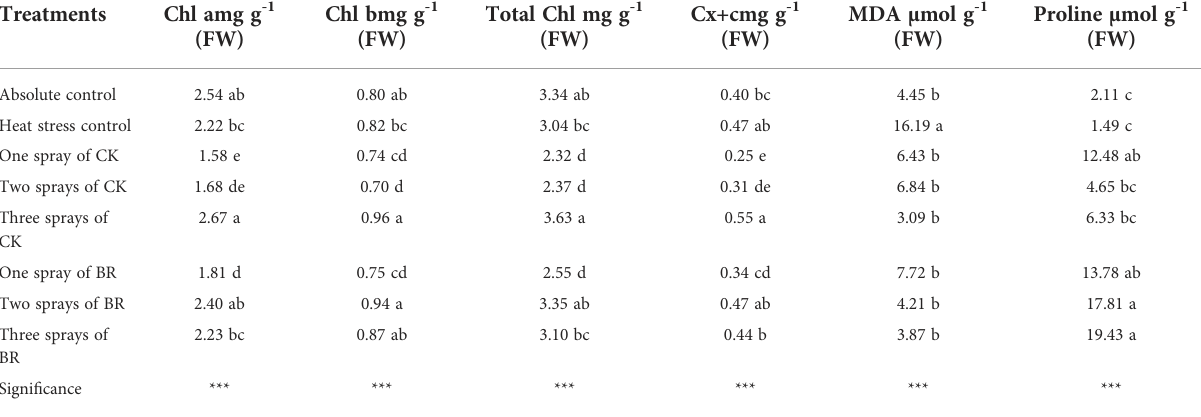
TABLE 3 Effect of the number of applications of two growth regulators (cytokinins (CK) or brassinosteroids (BR)) on biochemical variables in rice plants of genotype F2000 subjected to combined heat stress (40°C day/30°C night) at 88 days after emergence (DAE).